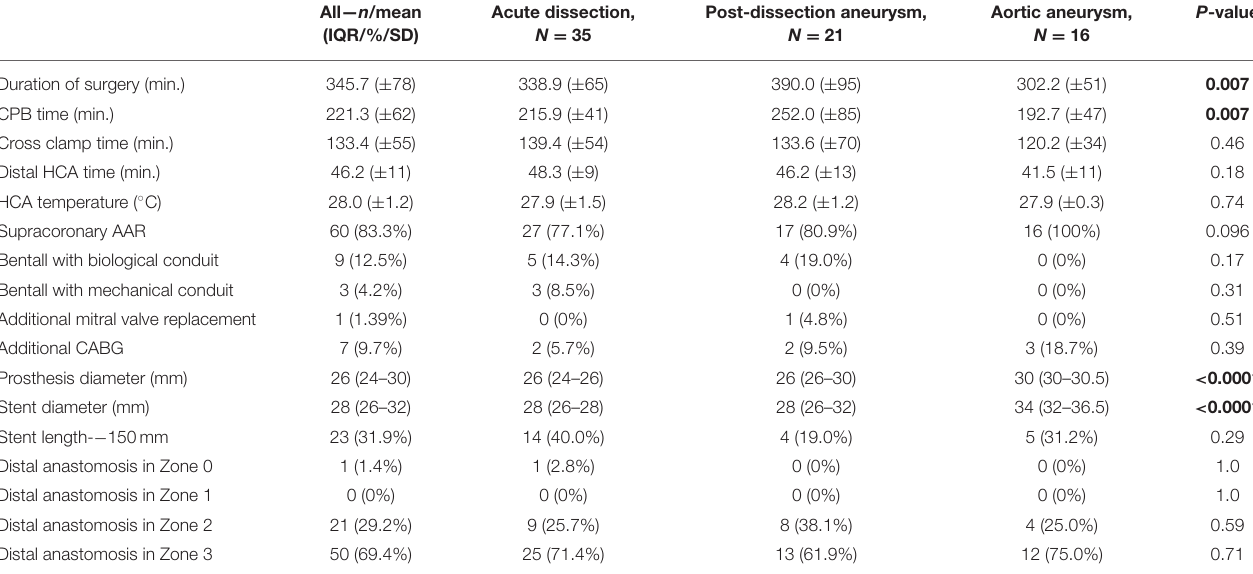
TABLE 2 | Intraoperative data.